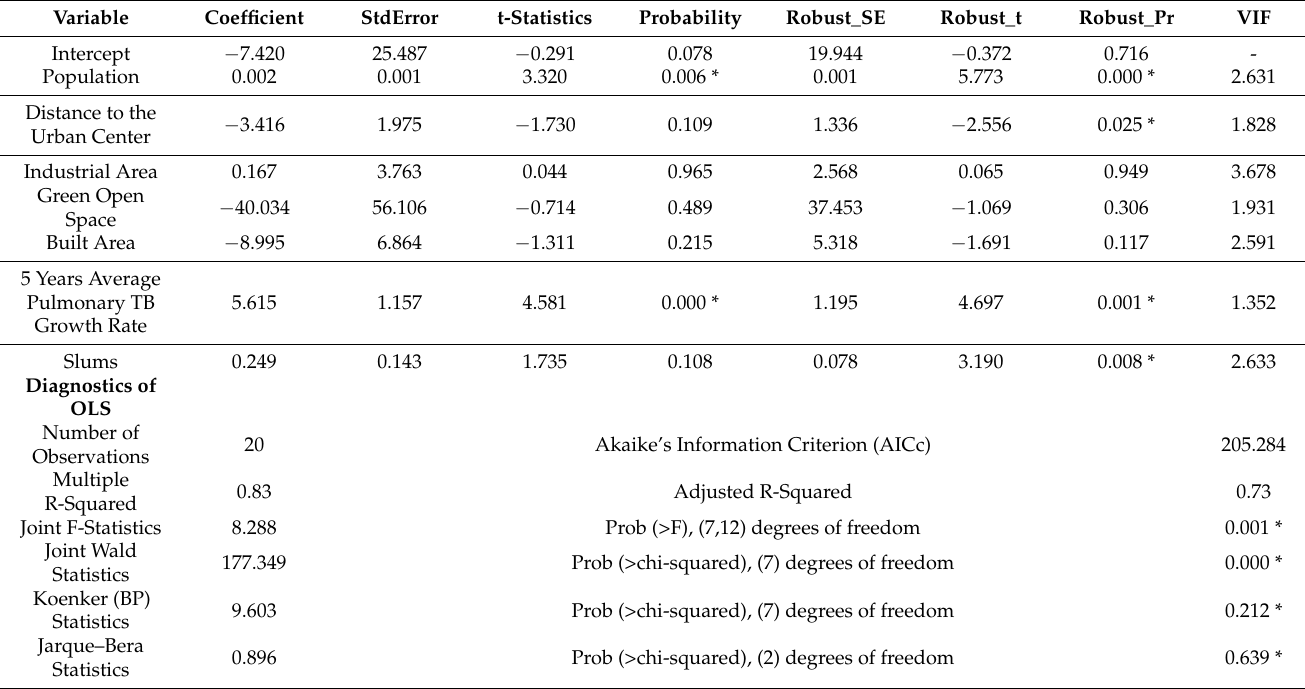
Table 2. Statistical summary of ordinary least square (OLS)